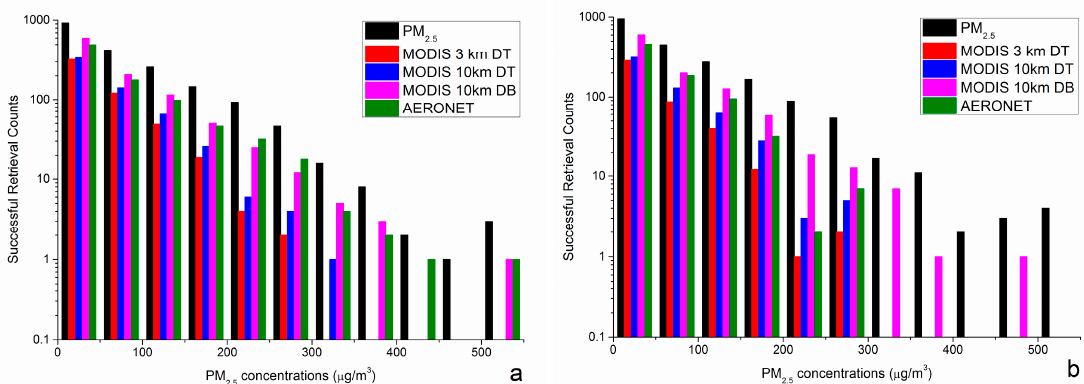
Figure 6. Retrieval number histograms of the MODIS 10 km Dark Target AOD, 10 km Deep Blue AOD,